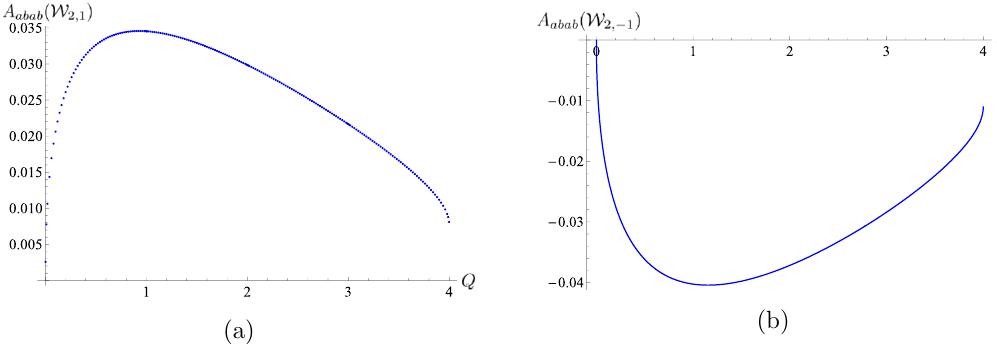
Figure 10 . The bootstrapped A abab ( W 2 , 1 ) on the left and the analytic A abab ( W 2 , − 1 ) on the right.